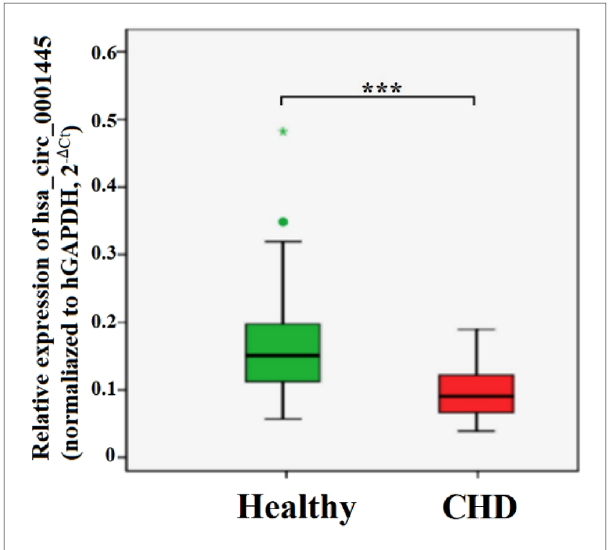
FIGURE 1 Expression levels of hsa_circ_0001445 in the healthy and CHD groups. p